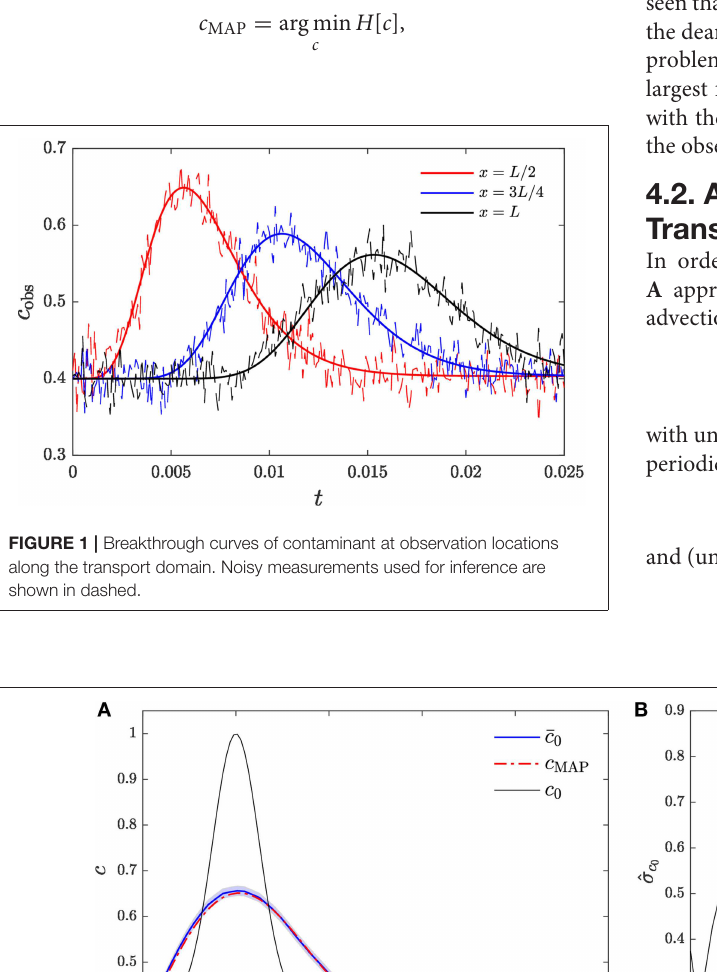
Frontiers in Environmental Science |